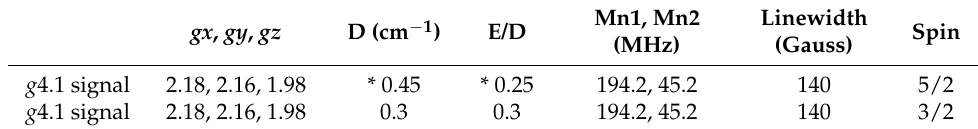
Figure 9. The experimental X-band CW-EPR difference g 4.1 spectrum and best-fit simulation as a rhombic spin 5/2 state (red spectrum, see Table 1). Spectrometer conditions: center field: 1650 G; frequency: 9.369115 GHz; microwave power 0.2 mW; sweep width: 2500 G; number of points 2500; number of scans: 5; temperature: 8 K; modulation amplitude 15 G (see Supplementary Materials S1). Table 1. Parameters used in g 4.1 signal (* fine structure terms similar to Haddy et al. 1992 [31]).